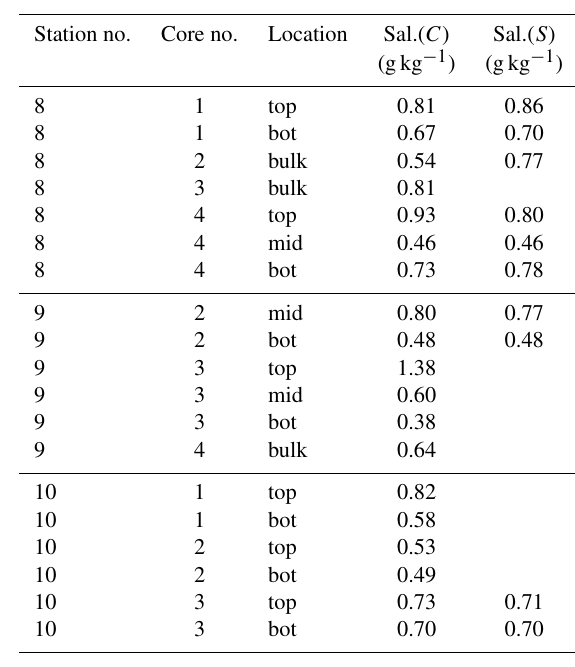
Table 2. Brine samples from stations 8 and 10. Sal.( C ) and Sal.( S ) are the absolute salinity measured with mini CTD and salinometer, respectively. Station